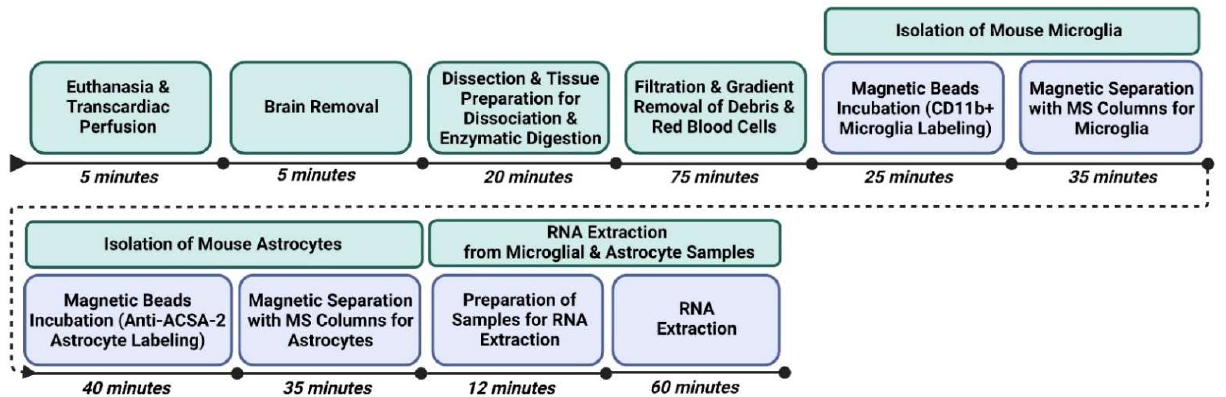
Figure 1. Sequential timeline of isolating microglia and astrocytes for downstream transcriptomic analysis with estimated time to completion. Note: RNA can be extracted at later time (within one week) once microglia and astrocyte samples are placed in TRIzol and can be stored at −20 ° C.